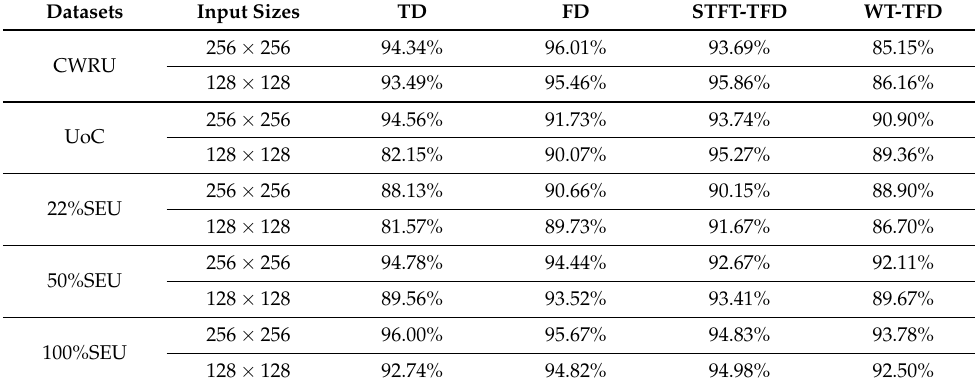
Table 12. Test accuracies of the evaluation with noise plus trend